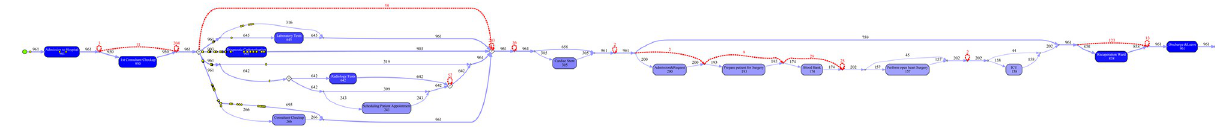
Fig 20. The process model explains the